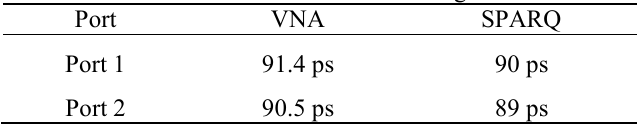
Table 2: Port extension for de-embedding connectors.